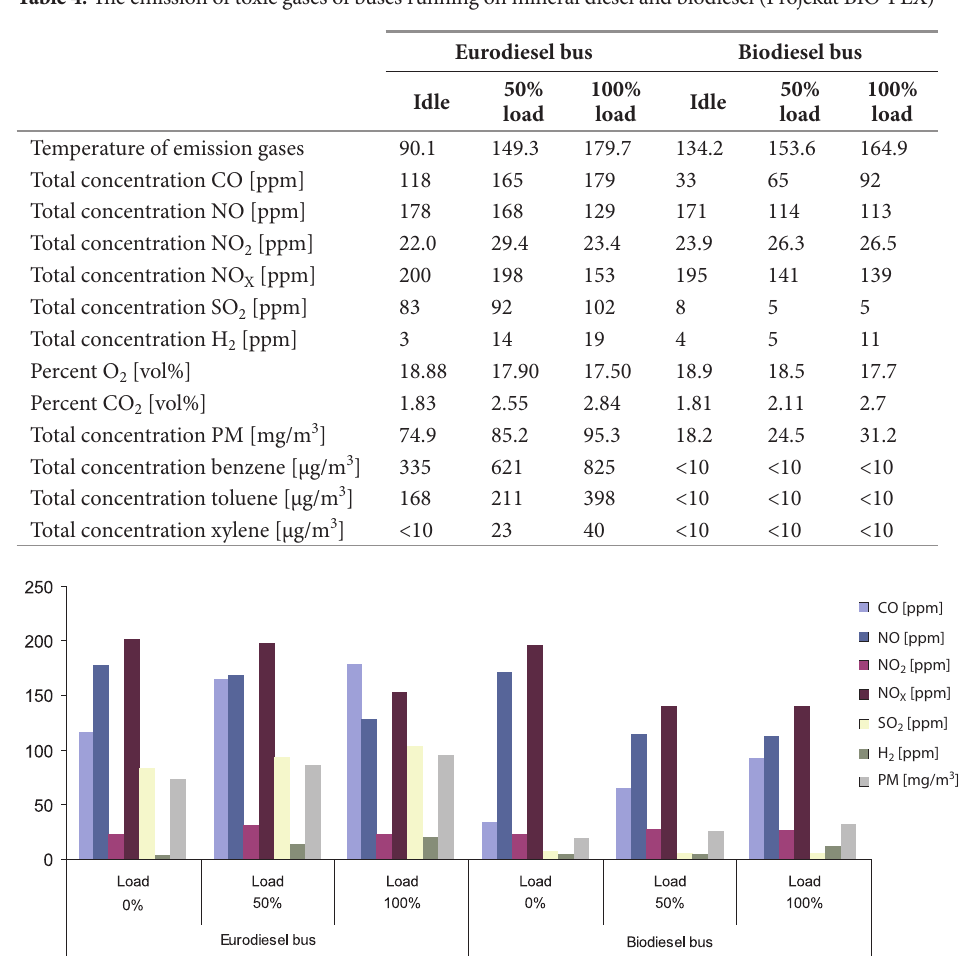
Table 4. The emission of toxic gases of buses running on mineral diesel and biodiesel (Projekat BIO-PEX)